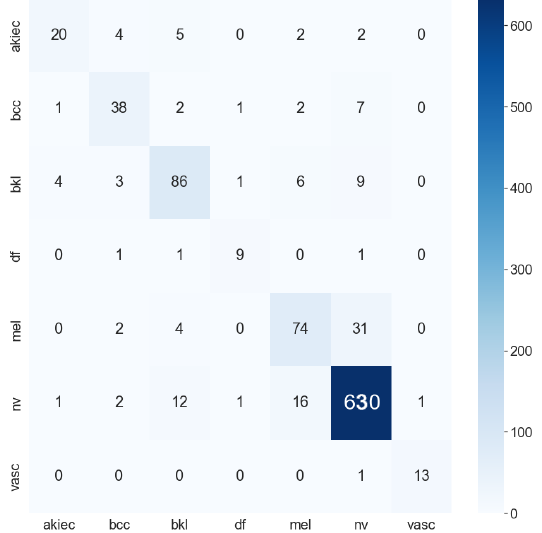
Figure 10. DenseNet201 confusion matrix.